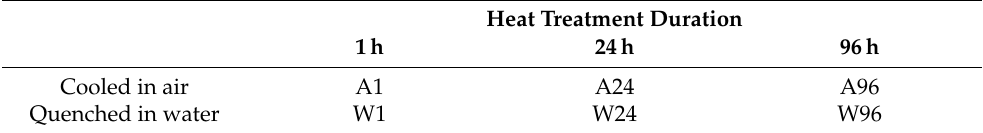
Table 1. Overview of the heat treatment parameters investigated and assignment to the sample group (e.g., A1 for 1h heat treated with subsequent cooling in air). All heat treatments were carried out at 500